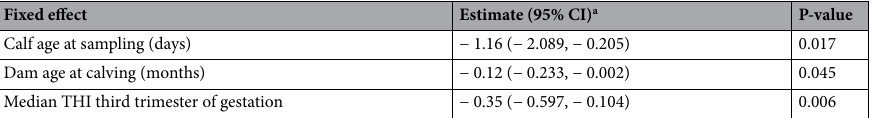
Table 3. Multivariable model (both primi- and multiparous dams included) adjusted from the variables that obtained P < 0.15 in the univariable analyses. a Estimates, with 95% confidence interval, presented as a % difference in TL for a 1-unit increase in the explanatory variable. Herd was included as a random factor and the log 10 transformed TL was used as the outcome variable.